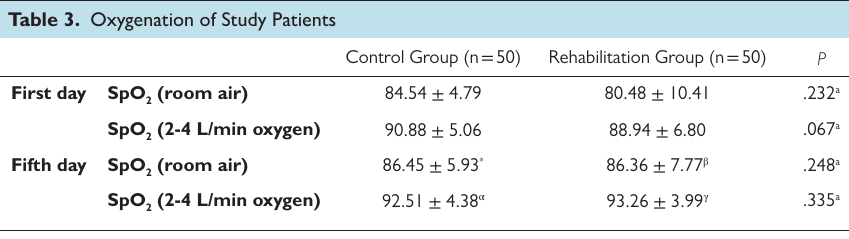
Table 3. Oxygenation of Study Patients